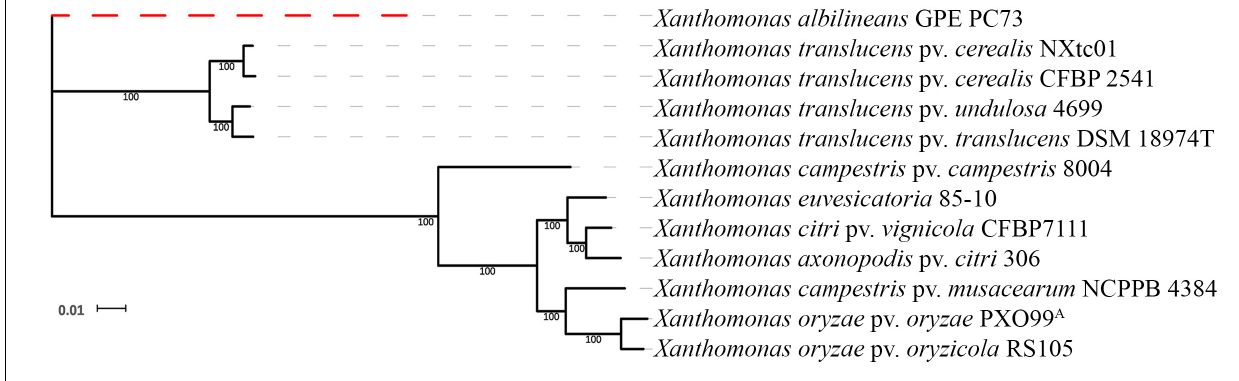
FIGURE 2 | Phylogenetic relationships based on single copy genes. The tree was constructed from a concatenated alignment of 1,270 single copy genes and shows the relationship of NXtc01 to the following Xanthomonas spp. (accession numbers in parenthesis): Xtc CFBP 2541 (PRJNA268946); X. translucens pv. undulosa 4699 (PRJNA248137); X. translucens pv. translucens DSM 18974T (PRJEB647); X. campestris pv. campestris 8004 (PRJNA15); X. euvesicatoria 85-10 (PRJNA341901); X. citri pv. vignicola CFBP7111 (PRJNA390891); X. axonopodis pv. citri 306 (PRJNA297); X. campestris pv. musacearum NCPPB 4384